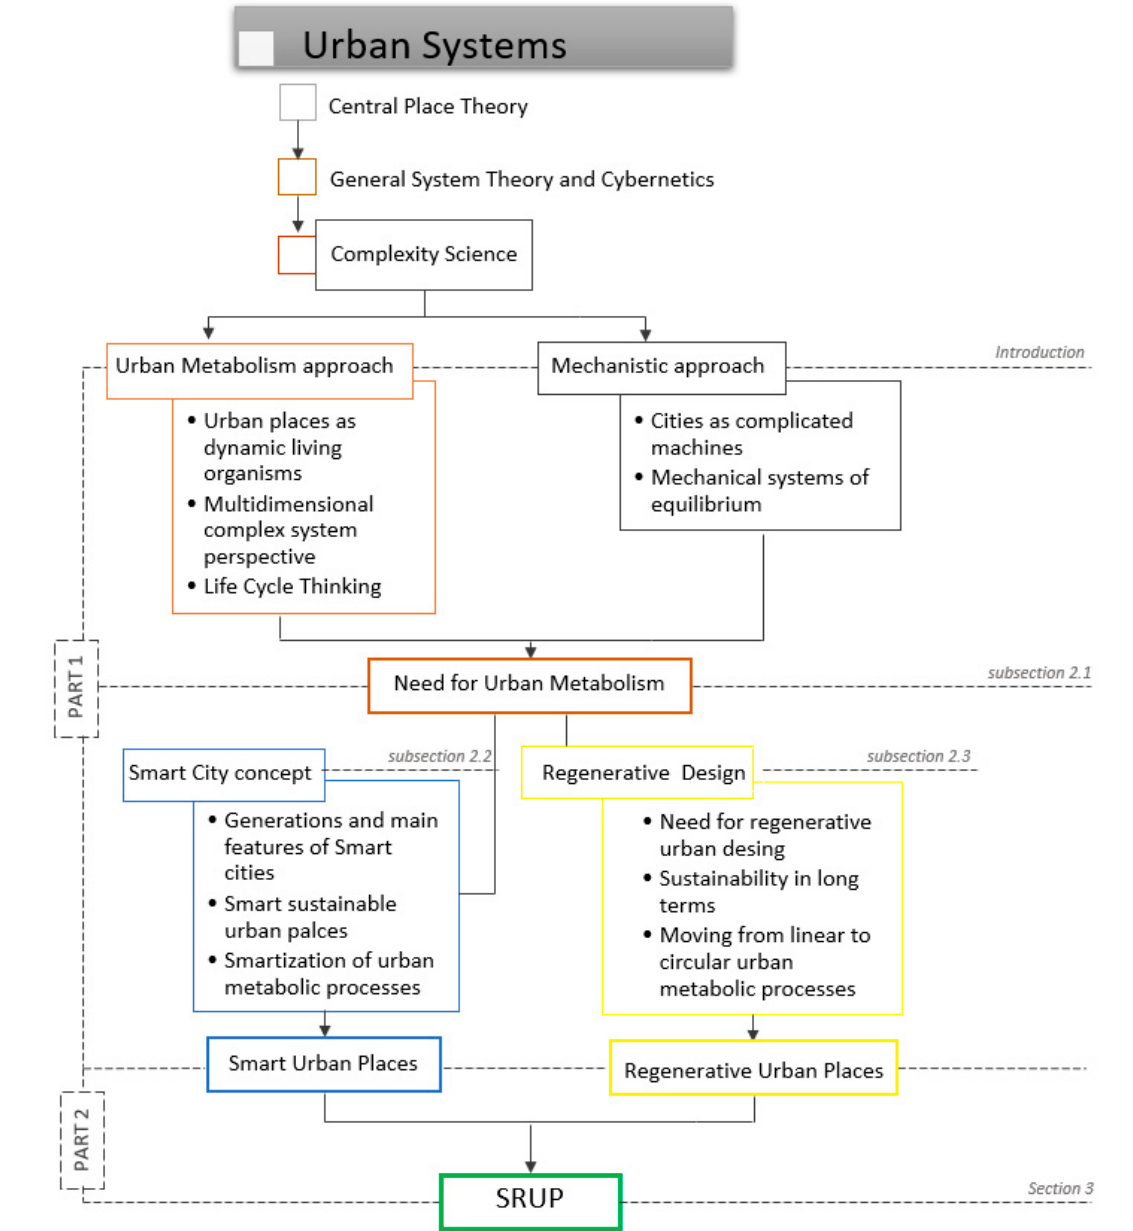
Figure 1. Conceptual framework analysis of Smart and Regenerative Urban Places